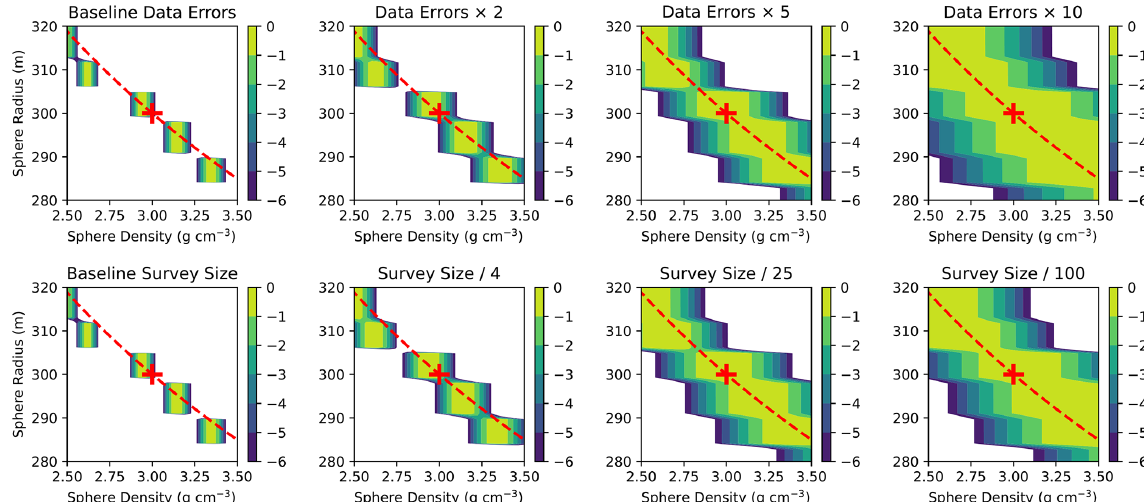
Figure 2. Influence of data error on the posterior distribution for the sphere inversion problem. The panels from left to right show the effects of multiplying the standard deviation of Gaussian noise on gravity observations by factors of 1 (baseline), 2, 5, and